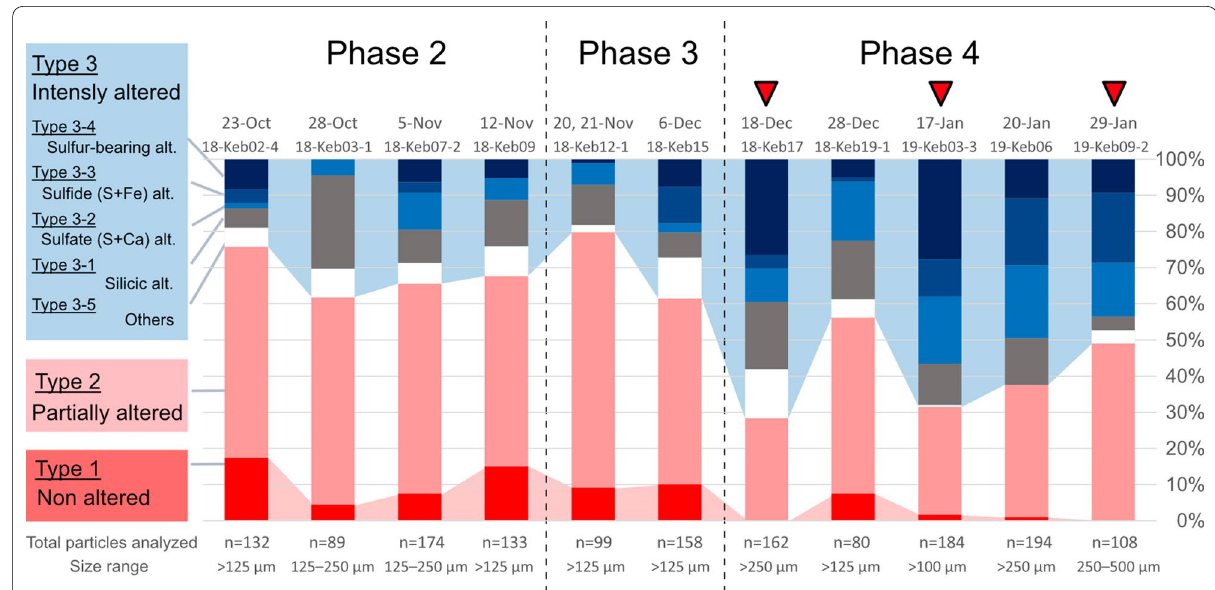
Fig. 8 The result of component analysis of the volcanic ash samples from the 2018–2019 eruption at Kuchinoerabujima Volcano. The number of analyzed particles is indicated at the bottom. Red triangles marked activities accompanied by PDCs and red triangles on the top of bars indicate particle types for which red-color change of some opaque minerals was observed (see